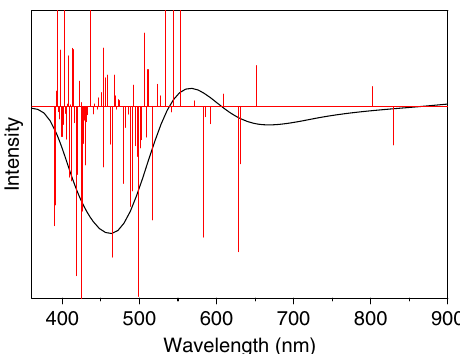
Fig. 6 Simulated ECD spectrum of the Ag 23 nanocluster. The theoretical band at 527 nm is split into two bands at 465 and 570 nm via